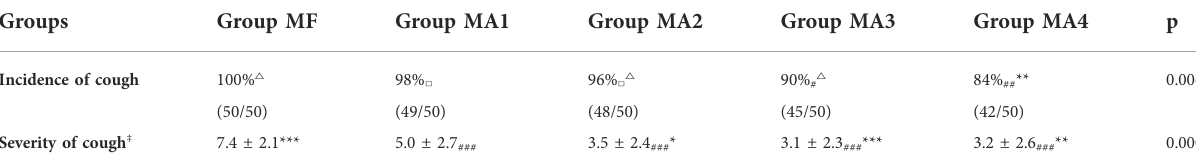
TABLE 3 Comparison of the fi ve groups with regard to cough severity (n = 50).